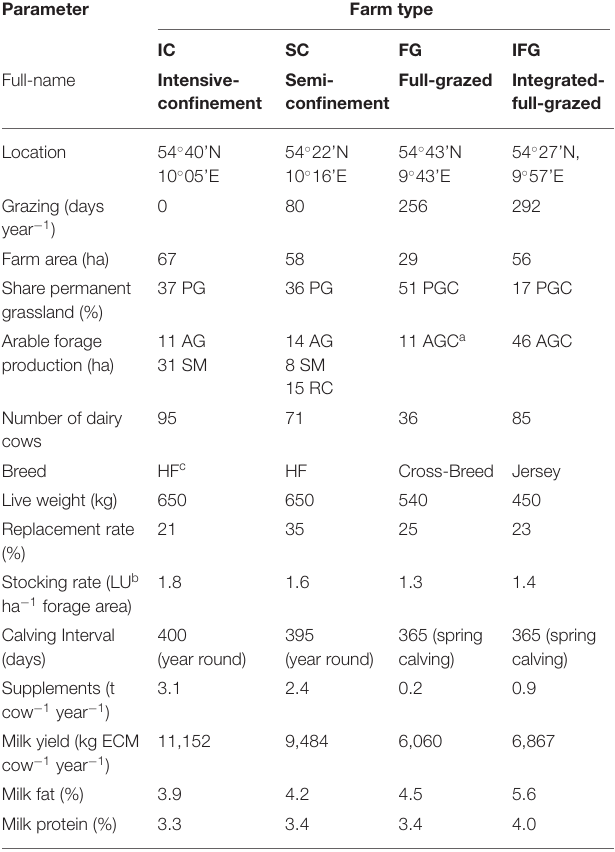
TABLE 1 | Overview of the prevailing dairy production systems available in the case-study-area as average of two experimental years.